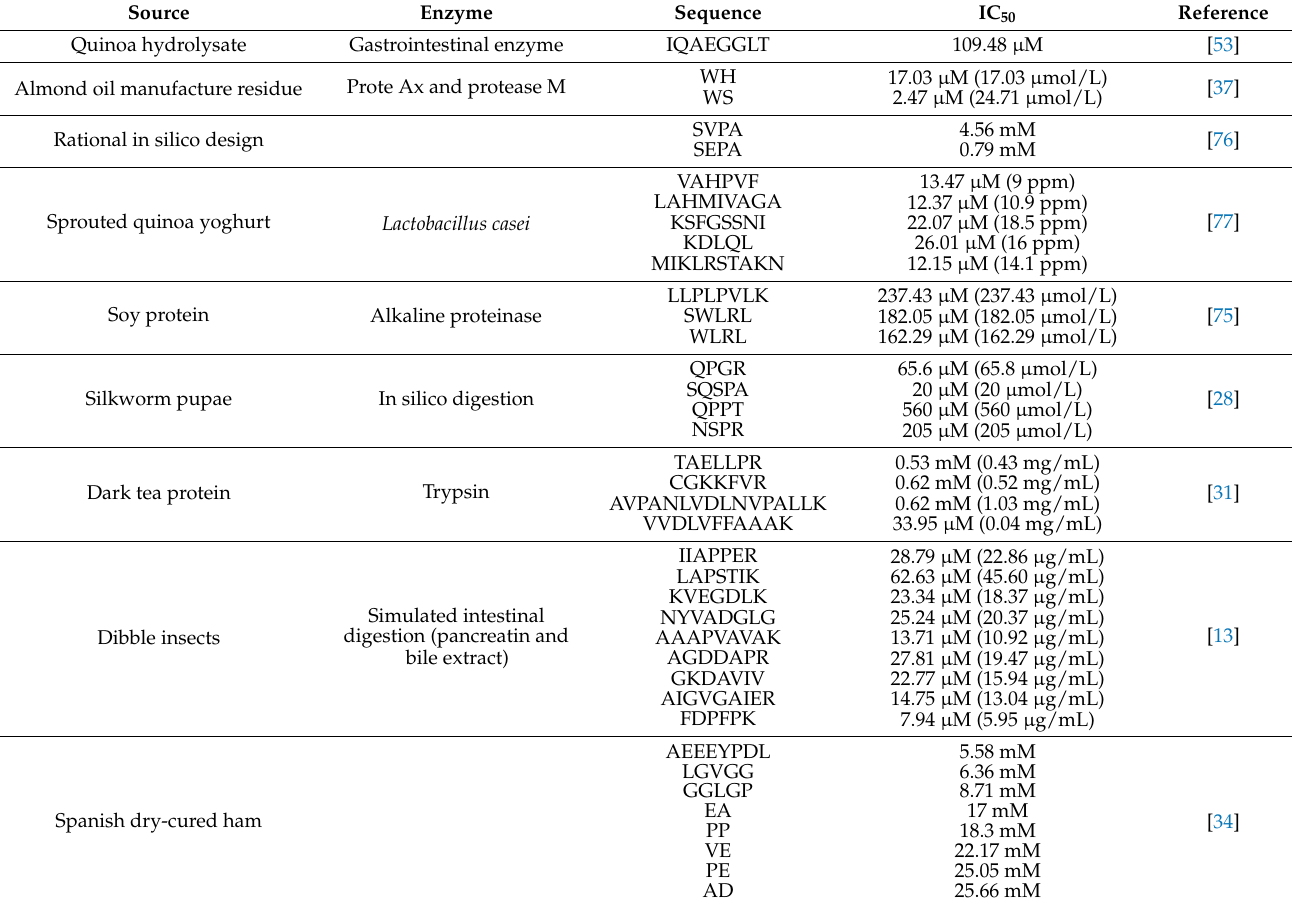
Table A1. Food protein-derived with α -glucosidase inhibition peptides